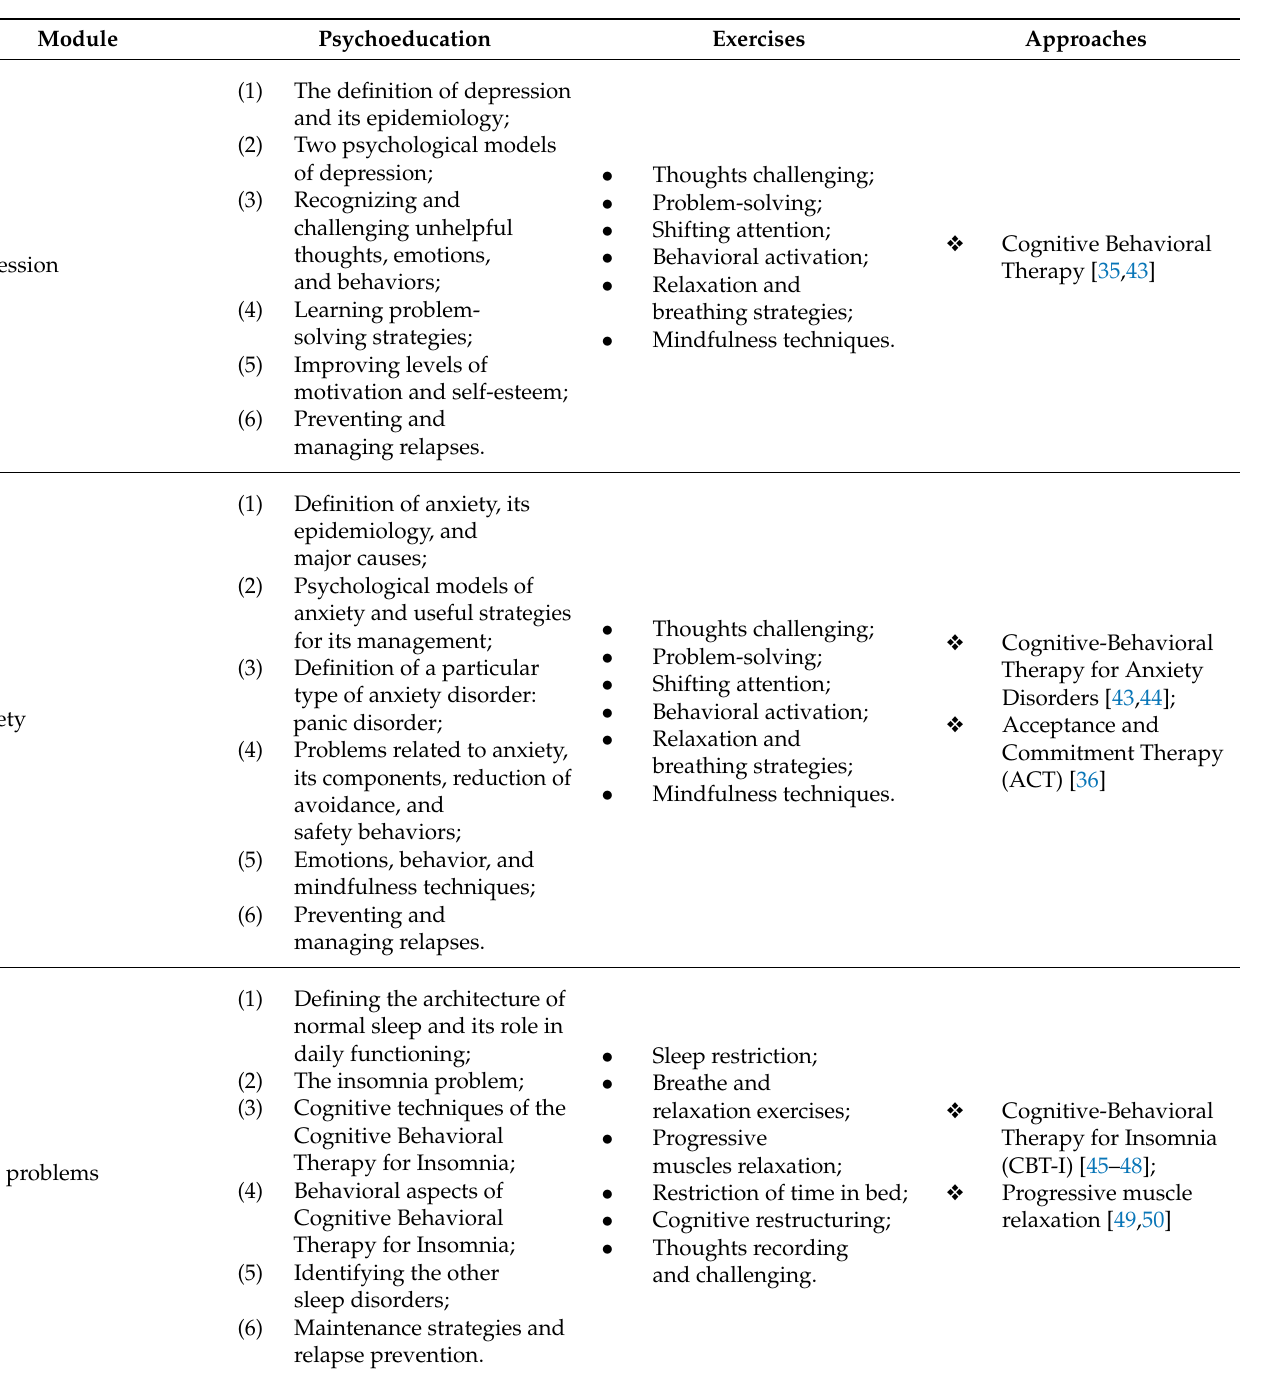
Table 1. Contents and approaches of each